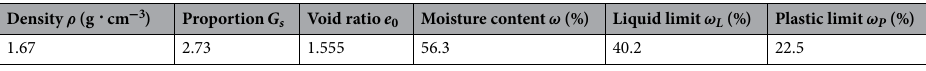
Table 1. Parameters of the